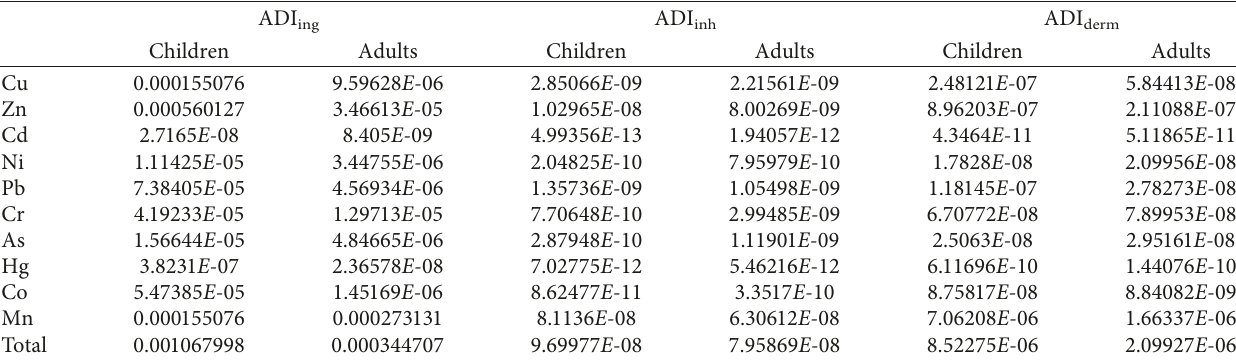
Table 3: Noncarcinogenic risk (HQ) of each (metalloid) heavy metal and total risks (HI). Children Adults HQ ing HQ inh HQ derm HI HQ ing HQ inh HQ derm HI